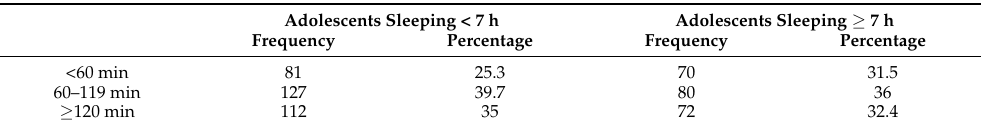
Table 3. Distribution of participants sleeping < 7 h or ≥ 7 h among the categories based on the duration of social jetlag. Frequency and percentage are shown.